Question: Looking at the figure, what chart type is it?
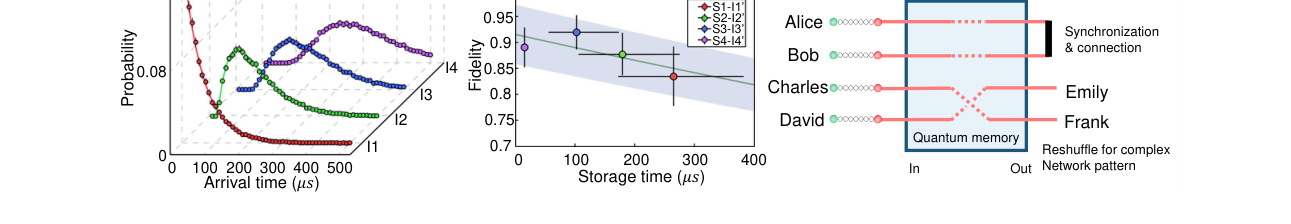
Answer: bar